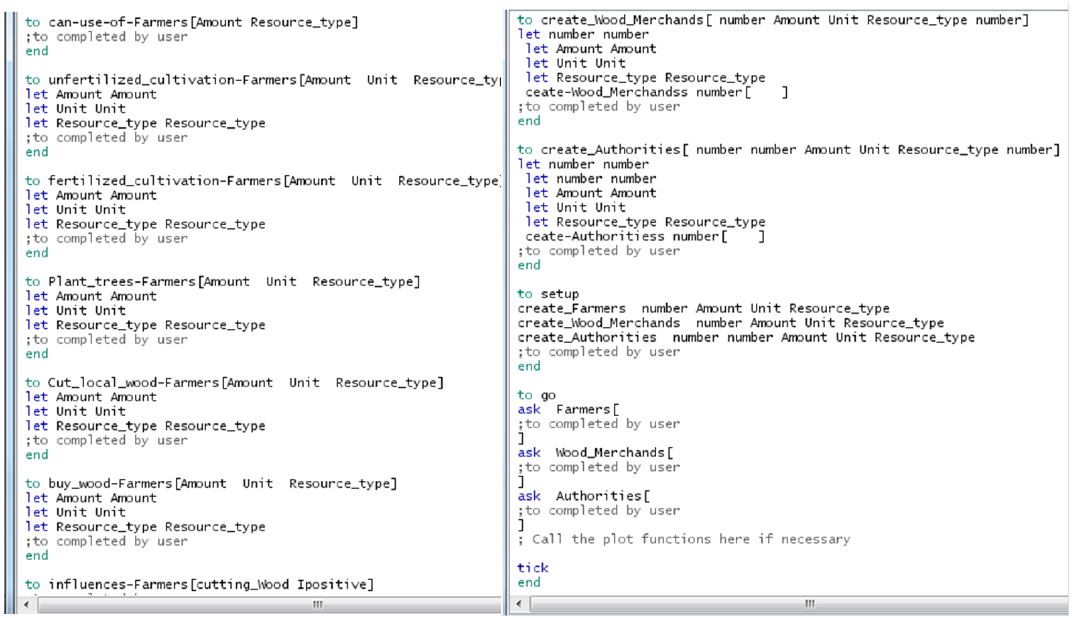
Figure 11. Laf Forest Reserve generating NetLogo code for function